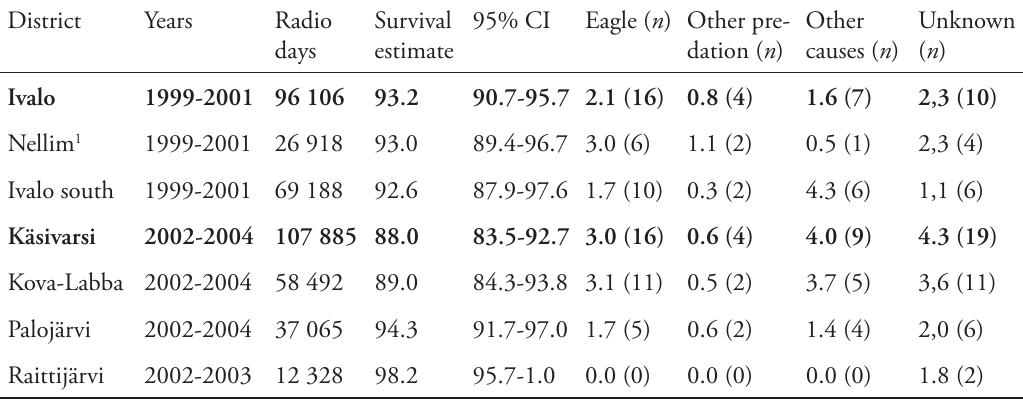
Table 1. Survival and cause-specific mortality estimates of radio-collared reindeer calves in the studied reindeer herding-cooperatives and herding-groups during study periods in 1999-2004. The survival and mortality estimates with 95% CI are calculated according to 2-week intervals using software Micromort 1.3. Number of death cases is in